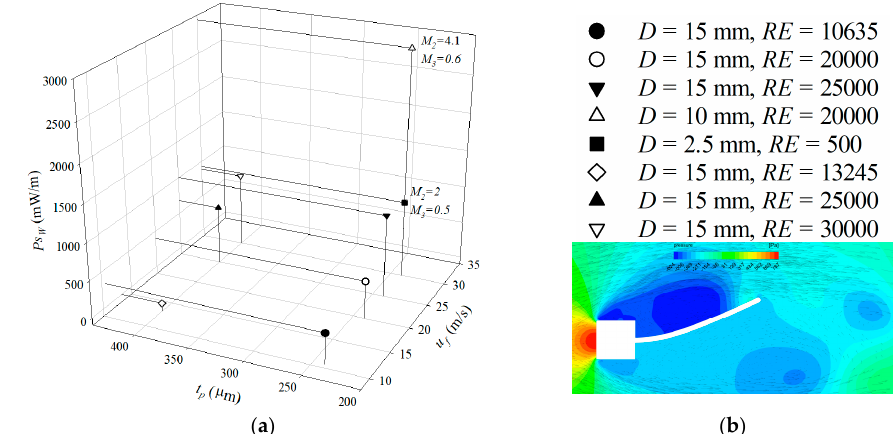
Figure 16. ( a ) Bending power P sW evolution with thickness and incoming velocity for L = 50 mm; ( b ) Mode 1 shape dominant bending pattern for the L = 50 mm, D = 15 mm, u f = 30 m/s, t p = 400 µm, highest strain energy shape, pressure contours and velocity vectors.